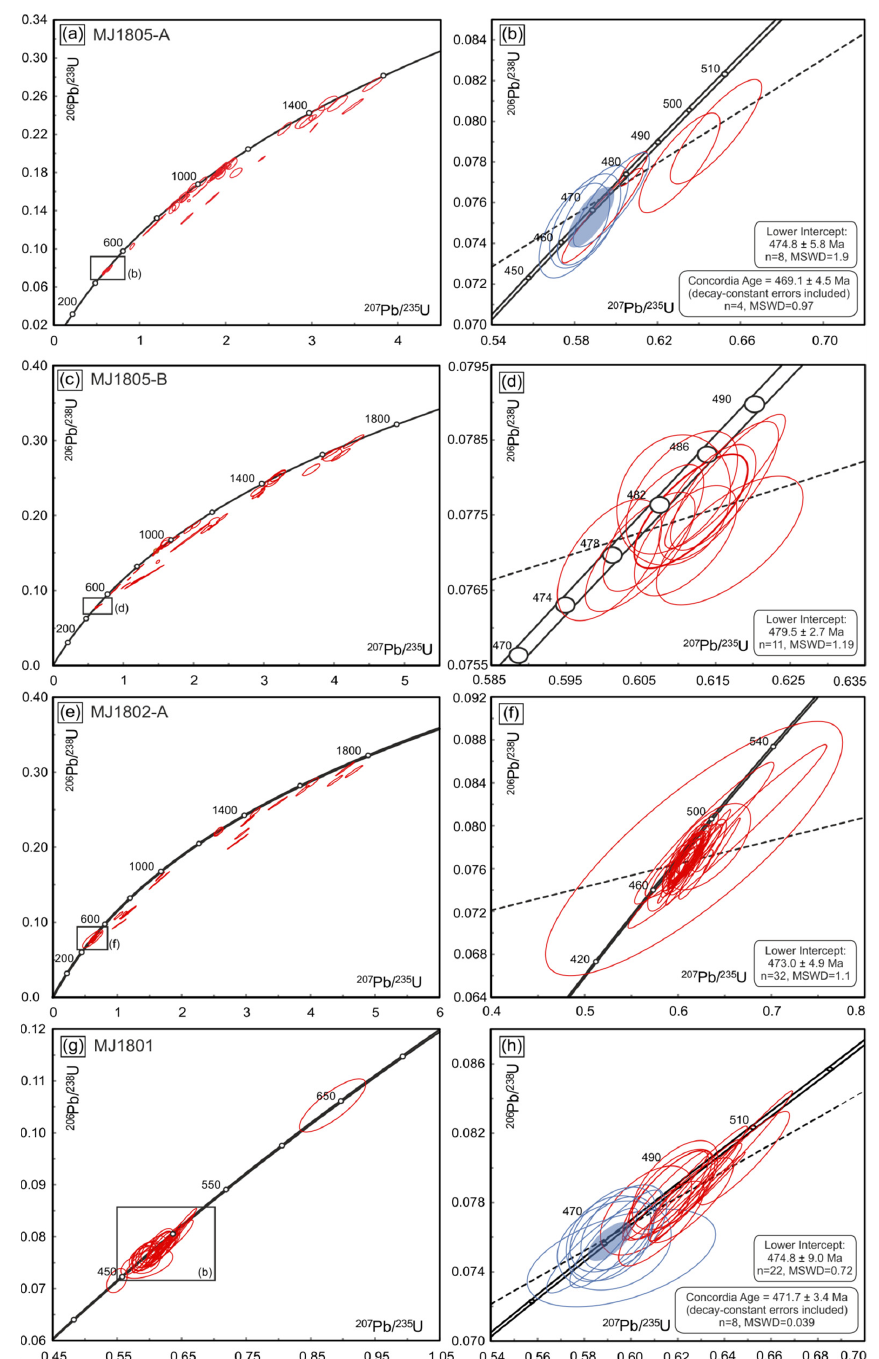
Figure 7. Concordia diagrams of zircon U-Pb analyses. ( a ) All analyses from sample MJ1805-A. ( b ) Caledonian age cluster from sample MJ1805-A. The lower intercept calculated for the whole cluster, concordia age calculated for the analyses marked by blue circle. ( c ) All analyses from sample MJ1805-B. ( d ) Caledonian age cluster from sample MJ1805-B. ( e ) All analyses from sample MJ1802-A. ( f ) Caledonian age cluster from sample MJ1802-A. ( g ) All analyses from sample MJ1801. ( h ) Caledonian age cluster from sample MJ1801. The lower intercept was calculated for the whole cluster, the concordia age was calculated for the analyses marked by blue circle.